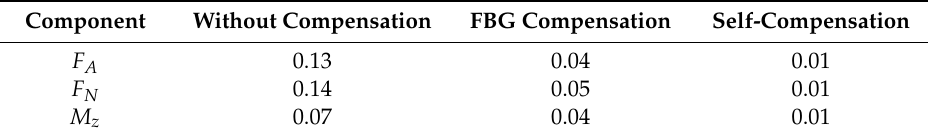
Figure 14. ( a ) Measured temperature changes in different parts of the balance according to FBG wavelength shifts, and ( b ) component outputs without temperature compensation, as well as those after ( c ) FBG compensation and ( d ) self-compensation. Table 4. Maximum thermal output of each component of the FFPI balance (unit: rad).